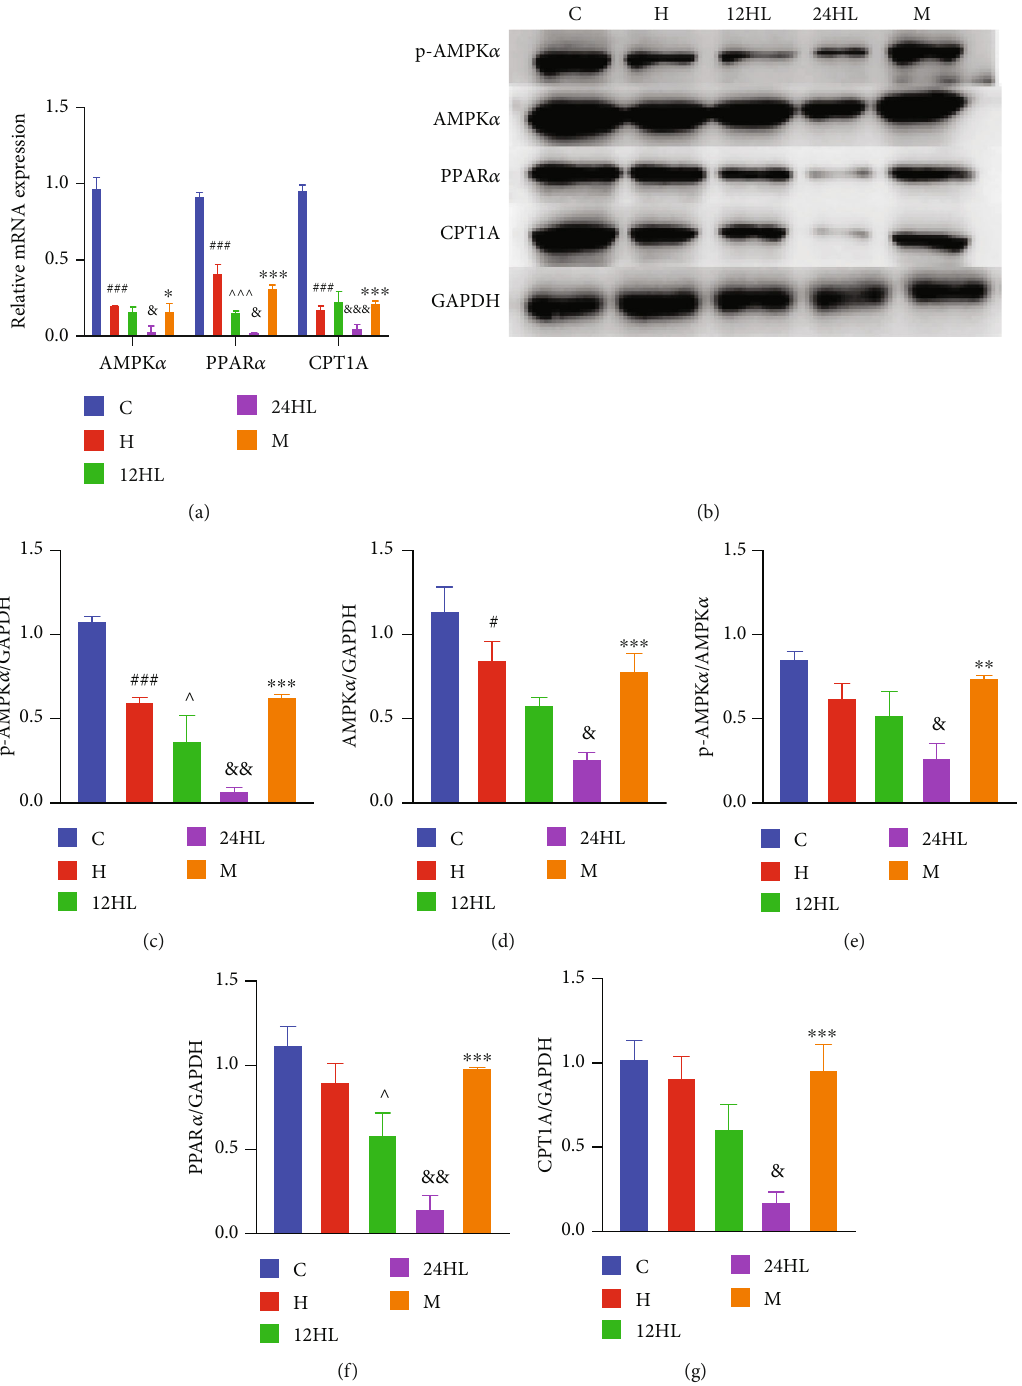
Figure 8: E ff ects of melatonin on AMPK signaling pathway-related mRNA and protein expression levels in guinea pig adipose tissue after treatment, at week 10. (a) AMPK α , PPAR α , and CPT1A mRNA expression as revealed by quantitative reverse-transcription PCR. (b) Western blotting of p-AMPK α , AMPK α , PPAR α , and CPT1A. p-AMPK α (c), AMPK α (d), p-AMPK α /AMPK α (e), PPAR α (f), and CPT1A (g) protein expression was quantitated by densitometry analysis of the bands. Values were normalized against that for GAPDH and analyzed with ImageJ software. C: control group; H: HFD group; 12HL: 12h light group; 24HL: 24 h light group; M: melatonin group; AMPK α : AMP-activated protein kinase α ; p-AMPK α : phosphorylated AMPK α ; p-AMPK/AMPK: protein ratio between p-AMPK and total-AMPK; PPAR α : peroxisome proliferator-activated receptor- α ; CPT1A: carnitine palmitoyl-CoA transferase 1 A;